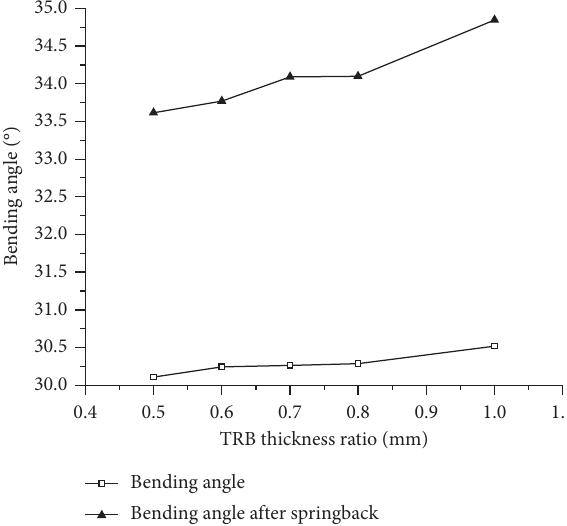
Figure 21: Curves of von Mises stress after springback.